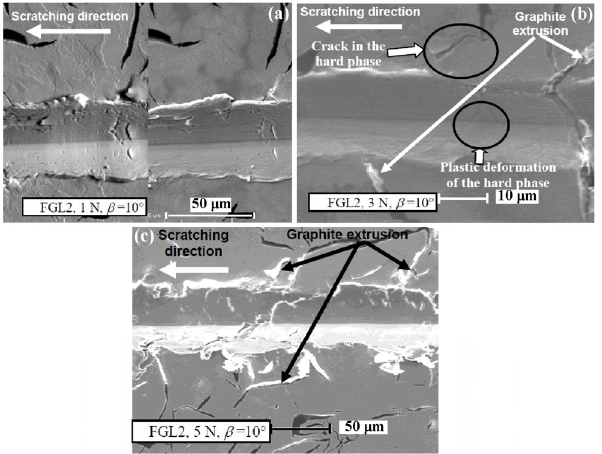
Fig. 8 Pearlitic matrix deformation and cracking of hard pho- sphorous eutectic, FGL2 iron, 2  = 160° (attack angle,  = 10°), F n = 1, 3, and 5